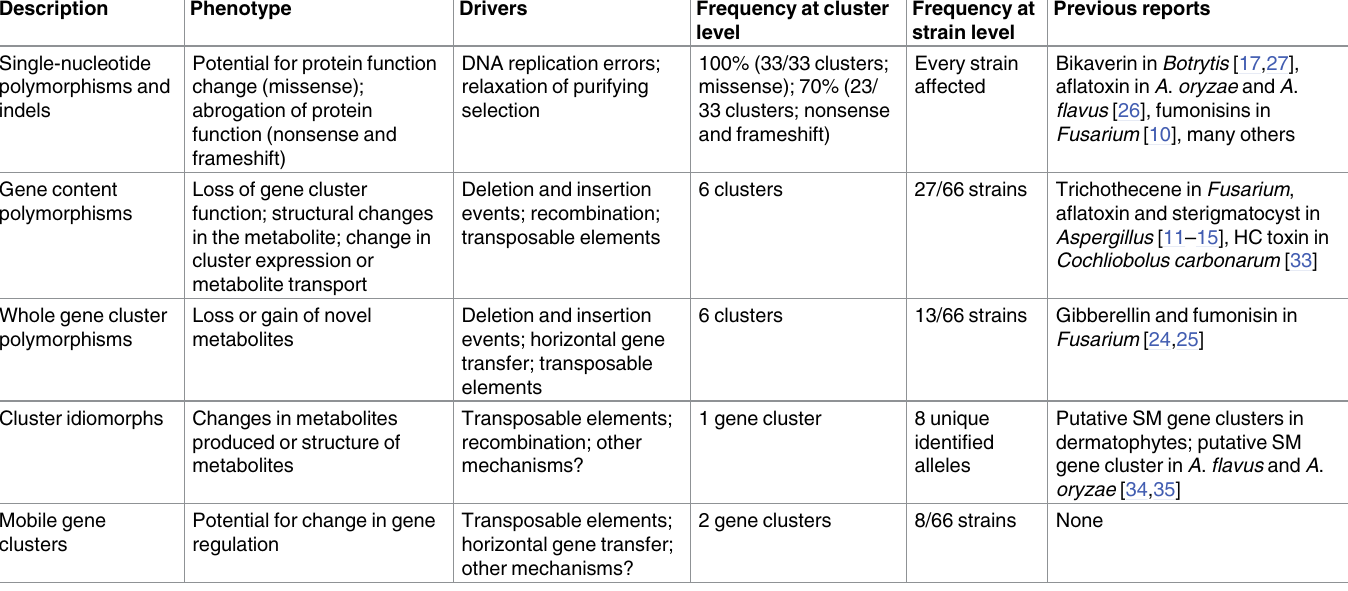
Table 1. Types and rates of SM gene cluster variants in Aspergillus fumigatus